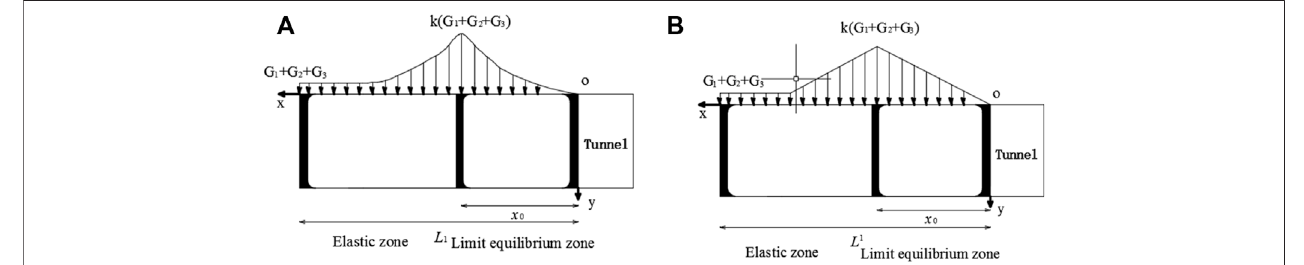
FIGURE 5 | Force model of solid coal wall. (A) Stress distribution model, (B) simpli fi ed model of force.